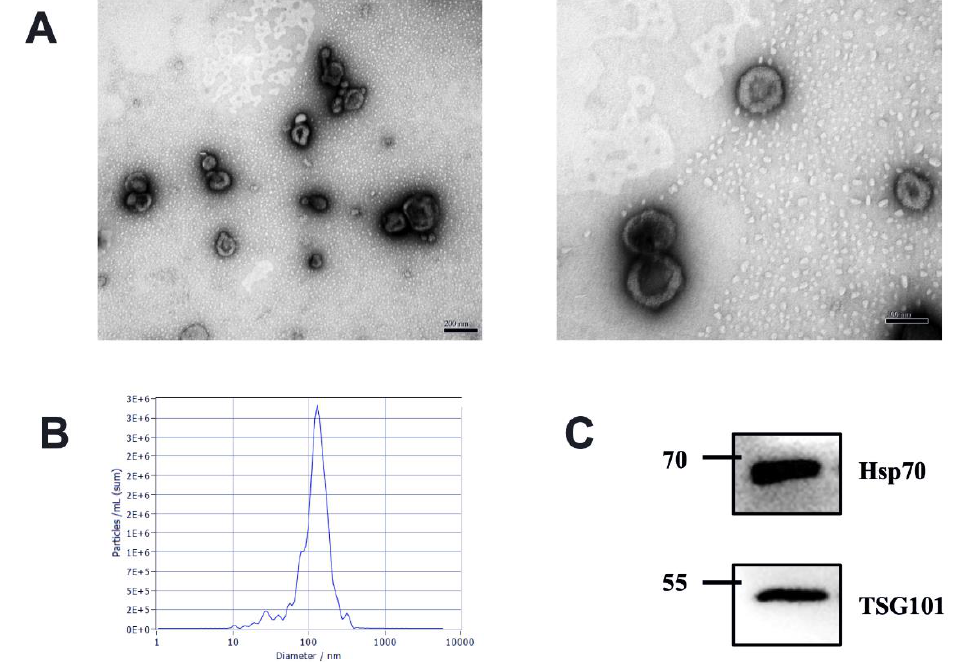
Figure 1. Characterization of EVs from bovine milk ( A ) Transmission electron microscopy observa- tion of milk-derived EVs, left, scale bar size 200 nm; right, scale bar size 100 nm; ( B ) Nanoparticle tracking analysis showing particle size distributions of milk-derived EVs. ( C ) Western blotting of exosome common markers TSG101 and Hsp70 in milk-derived EVs (original western blot figures in Figure S1) .